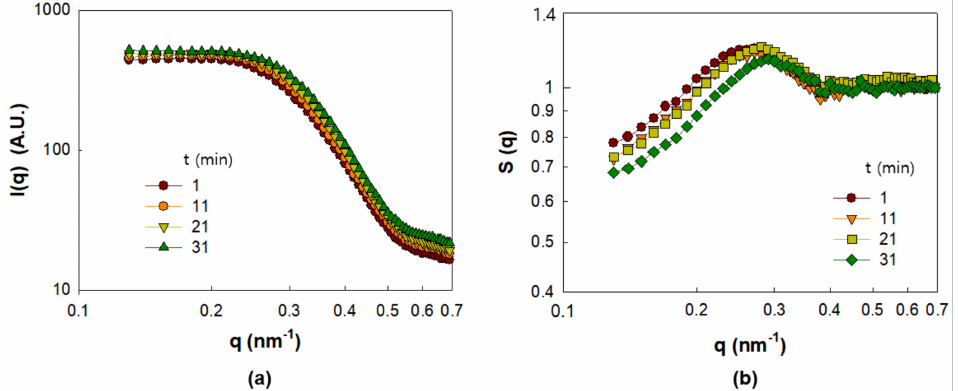
Figure 5. SAXS analysis results of PNC film corresponding to Γ 0.09 for drying times up to 31 min. ( a ) I(q) and ( b )